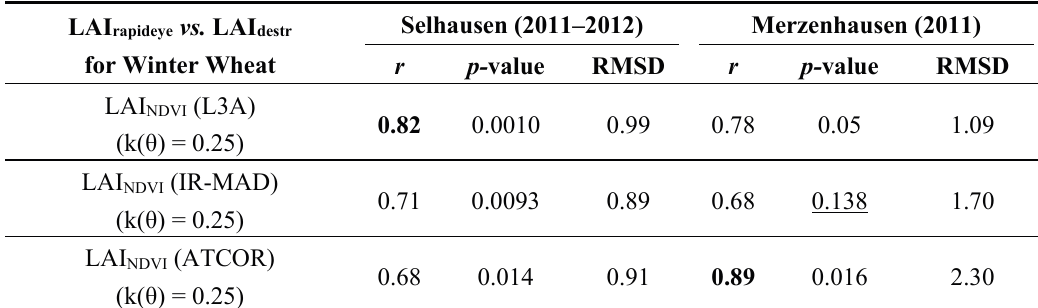
Table 3. Comparison of the LAI NDVI (RapidEye standard L3A, IR-MAD and ATCOR processed) with LAI destr , in winter wheat fields at Selhausen and Merzenhausen test sites. (Numbers in bold represent the best correlation in a column while underlined numbers represent the insignificant